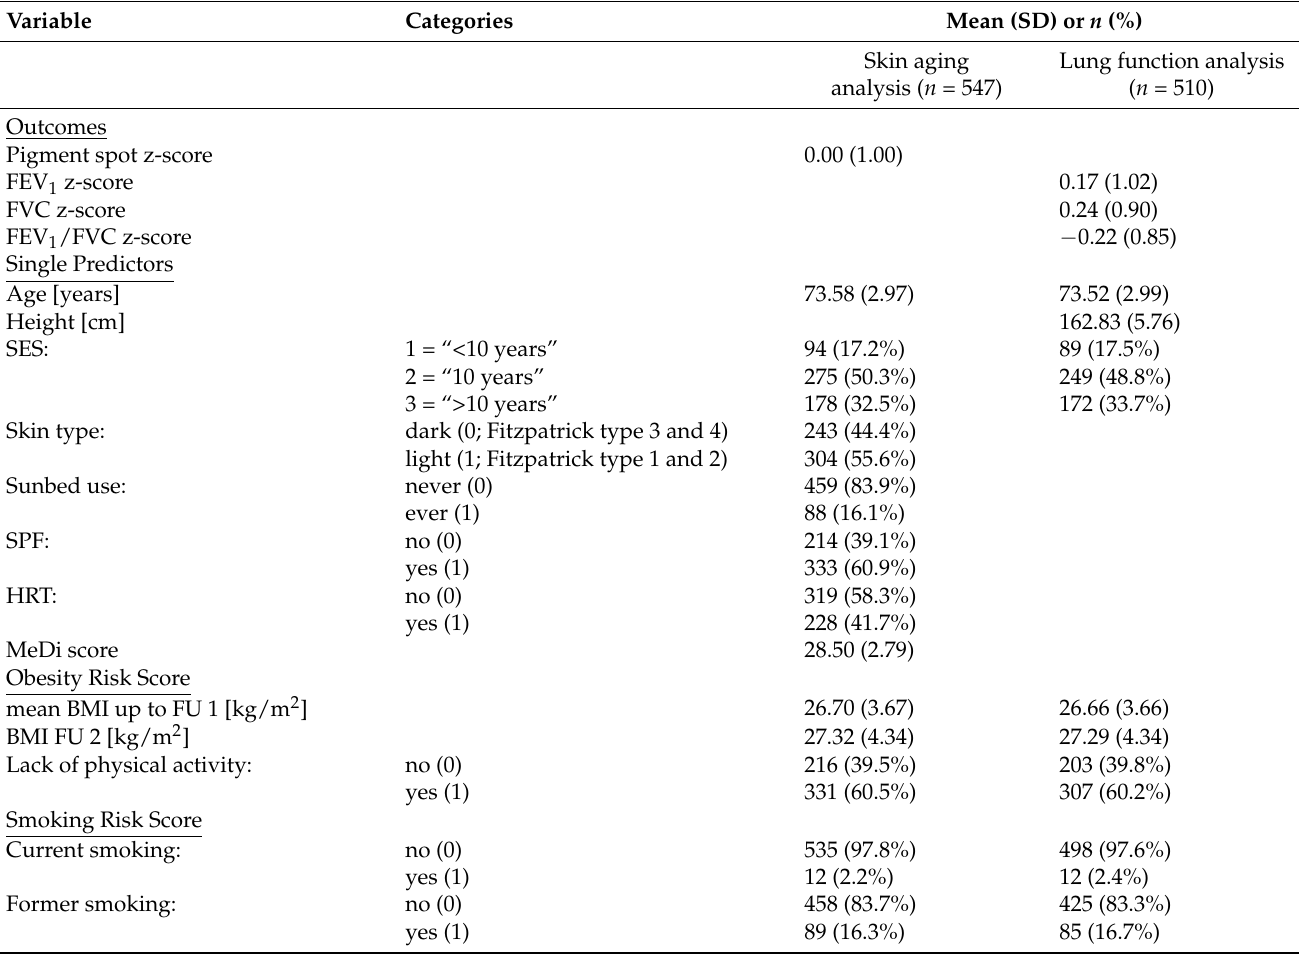
Table 1. Descriptive statistics of all outcome and predictor variables in both analysis